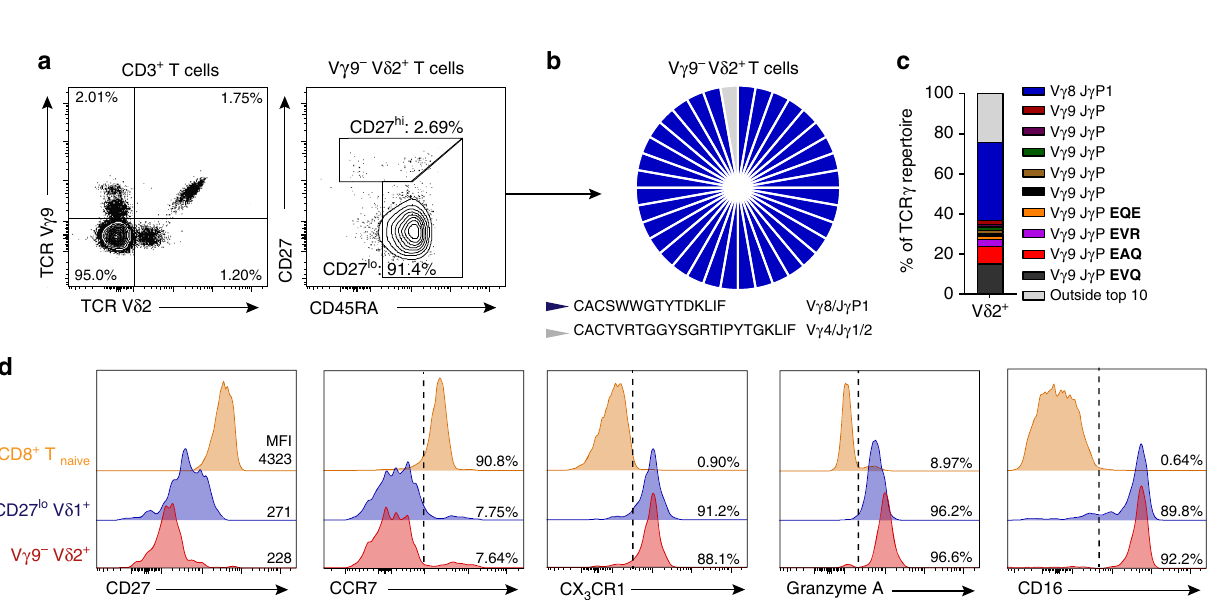
Fig. 4 V γ 9 − V δ 2 + T cells undergo clonal expansion. a Identi fi cation of V γ 9 − V δ 2 + T cells (left) and CD27/CD45RA T-cell memory marker expression on V γ 9 − V δ 2 + T cells (right) in a peripheral blood sample from “ donor X ” . b Single-cell CDR3 δ sequence analysis and V γ usage by V γ 9 − V δ 2 + T cells sorted from a peripheral blood sample from “ donor X ” . c TCR γ repertoire analysis of V δ 2 + T cells from “ donor X ” , highlighting the frequency of “ donor X ’ s ” V γ 9 − V δ 2 + T-cell clone (from b ) within the top 10 most prevalent clonotypes, highlighted are prevalent V γ 9 + clonotypes (EVQ, EAQ, EVR and EQE). d Analysis of naive and effector T-cell marker expression by V γ 9 − V δ 2 + , CD8 + CD27 hi CD45RA hi (CD8 + T naive ) and CD27 lo/neg V δ 1 + T-cell populations from a peripheral blood sample from “ donor X